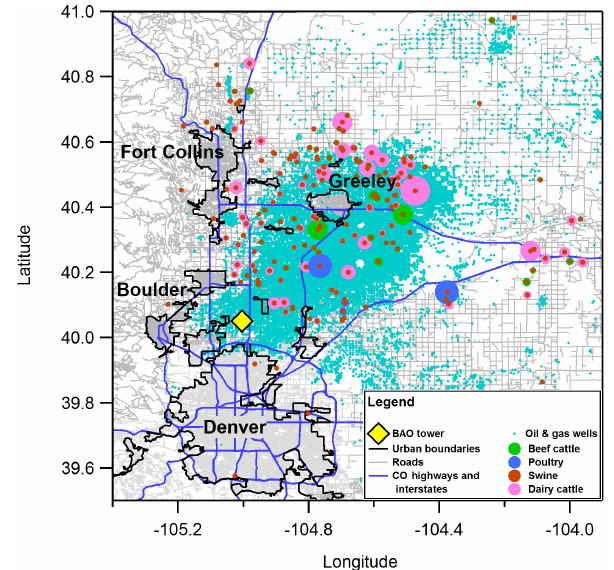
Figure 1. Area surrounding the BAO site, including major nearby urban municipalities, roads and highways, ONG wells, and CAFOs. CAFOs are colored by operation type and sized by number of ani- mal units per operation.